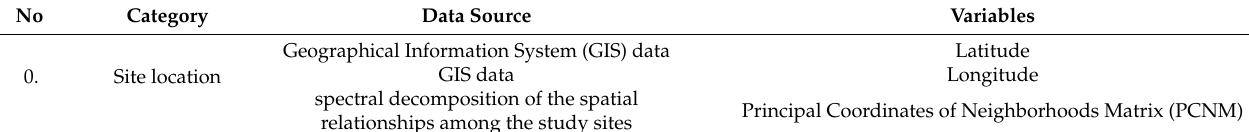
Table 1. Explanatory variables used to explain the patterns observed in the structure of the riparian invertebrate community and assess the role of the riparian forested